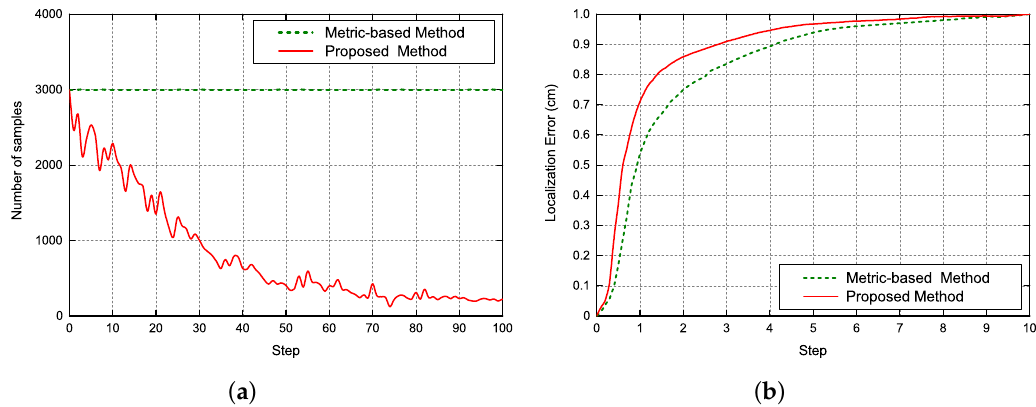
Figure 10. ( a ) A typical evolution of number of samples in global localization. ( b ) CDF of localization